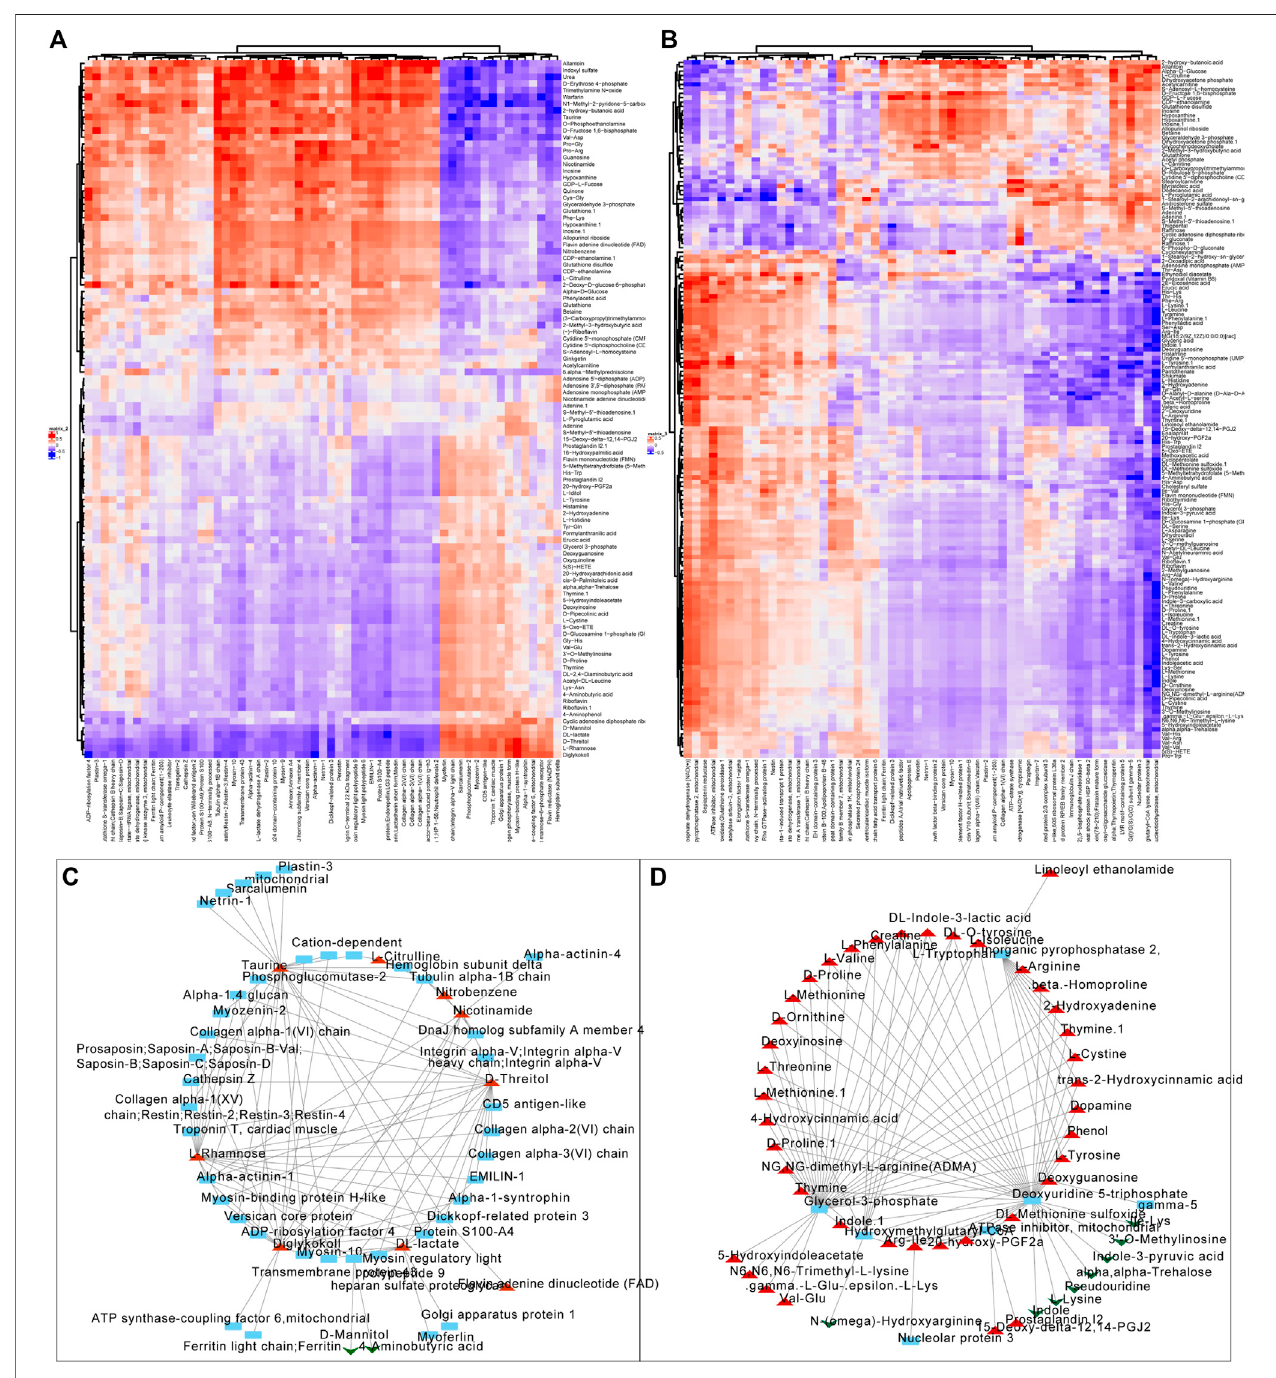
FIGURE 5 | Correlation analysis of the differentially expressed proteins with metabolites. (A,B) The correlation analysis of differentially expressed proteins with metabolitesinvalvularAF (A) andnon-valvularAF (B) . (C,D) WeconstructeddifferentiallyexpressedproteinsandmetabolitesinteractionnetworksinvalvularAF (C) and non-valvular AF (D)